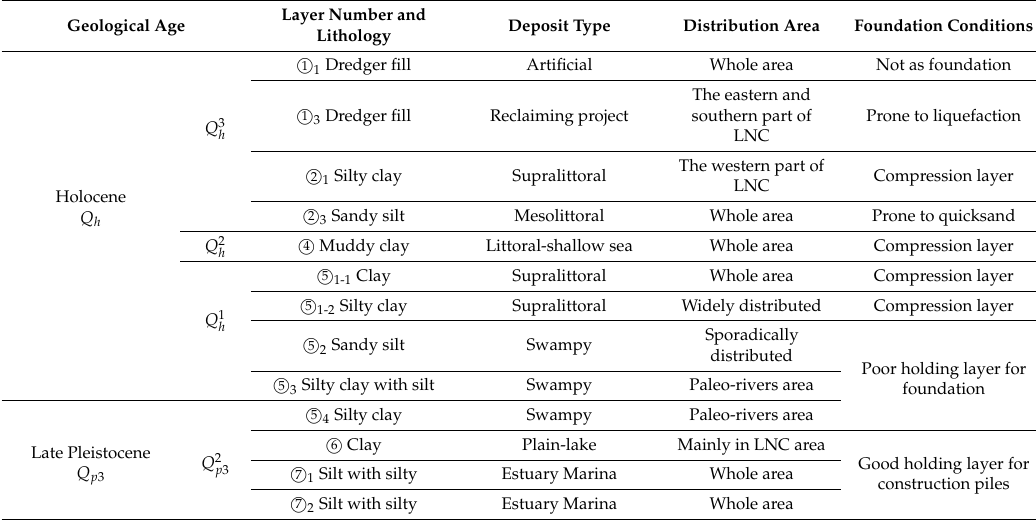
Table 4. The division of engineering geologic layers in